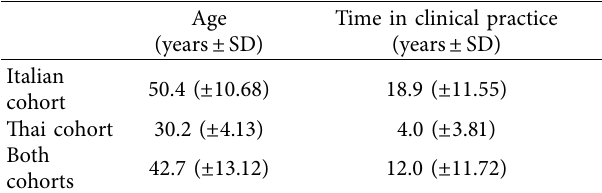
Table 1: Demographic data of the psychiatrists responding to the